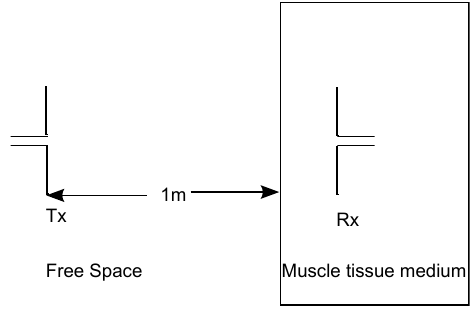
Figure 1. Propagation of the waves from lossless to lossy medium: Air to